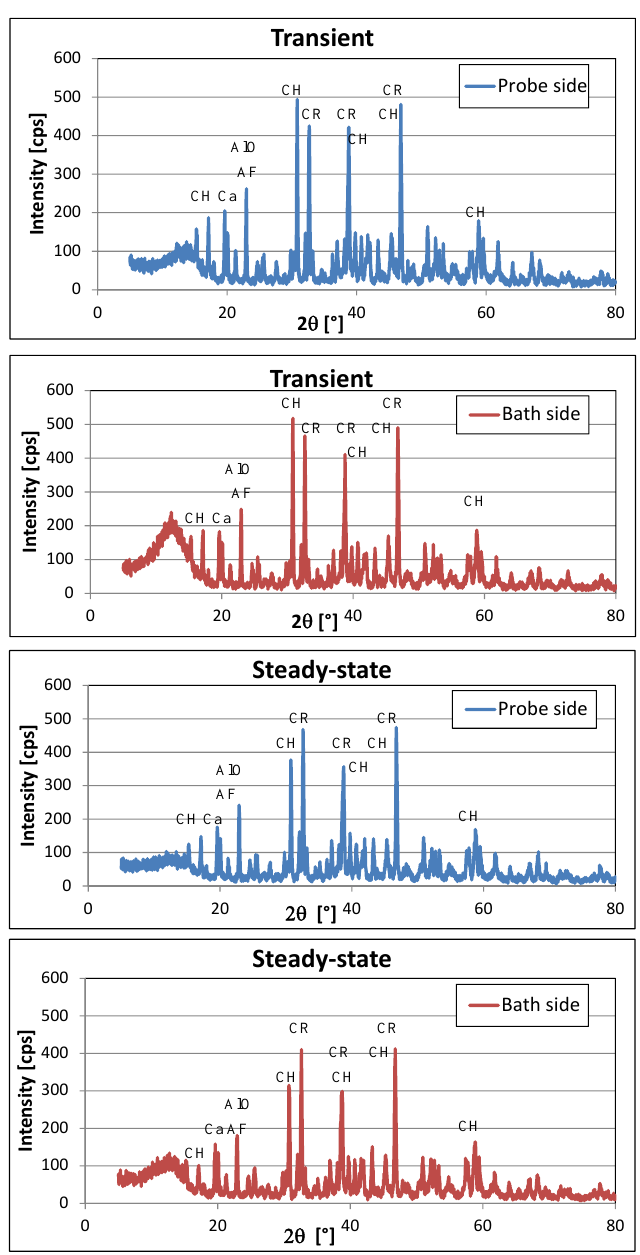
Figure 2. Variation of the intensity of diffracted X ‐ ray beams with 2 θ for TP, TB, SP, SB samples obtained with X ‐ ray Diffractometer (XRD); cps denotes “count per second”, CR: cryolite, CH: chiolite, AF: AlF 3 , AO: Al 2 O 3 , Ca: calcium containing complex ions.